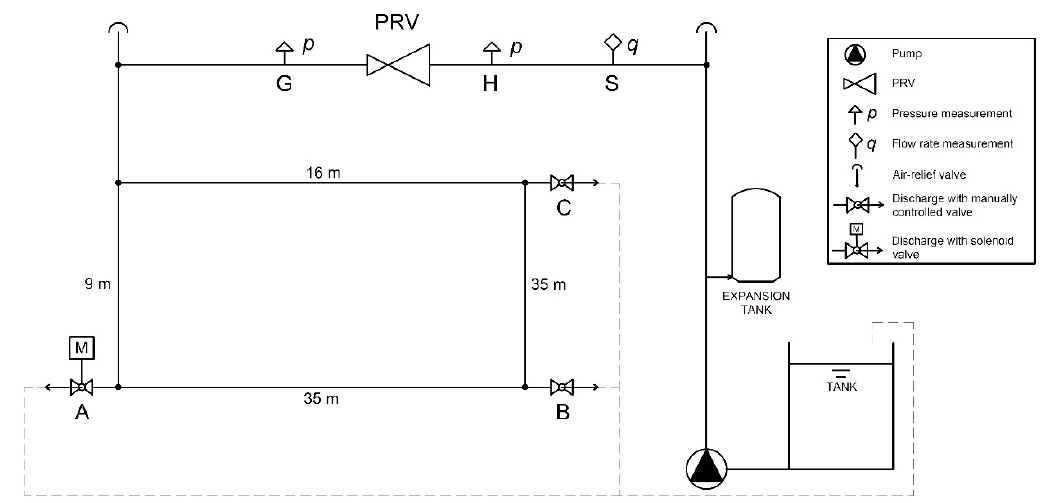
Figure 3. Layout of the testbed installed in the Hydraulics Laboratory of the University of Ferrara.